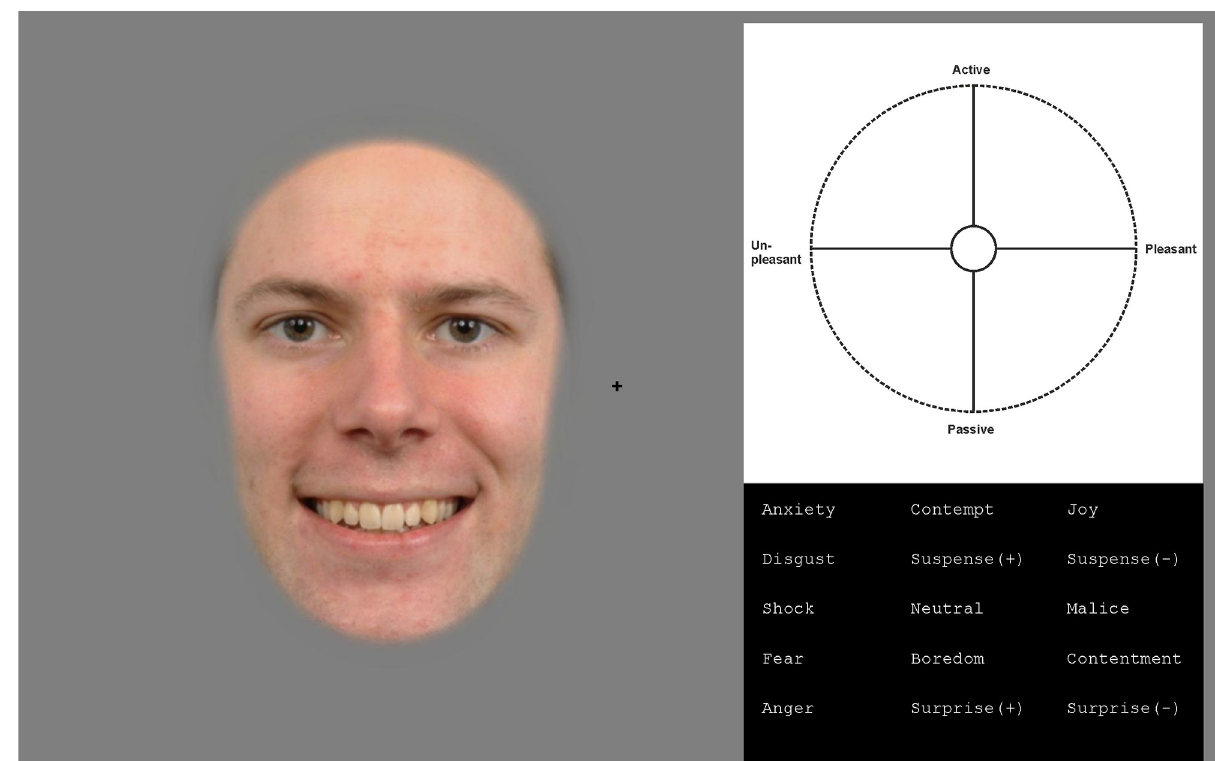
Fig 1. Example of the stimulus display presented to participants at the beginning of a trial. During each trial one facial image was presented on the left side of the screen and the V-A space and the term list (black background) on the right side of the screen. The participants’ task was to first give a rating within the V-A space (top right) and then to select 1–2 terms (bottom right) that best described the emotional expression of the presented face. The participant had up to 3.5 seconds to view the facial image on left, after which it disappeared. The expression portrayed in the example here represents a happy mouth combined with neutral eyes. The example face image is adapted from Radboud faces database (http://www.socsci.ru.nl:8180/ RaFD2/RaFD?p=main). The copyright holder, Radboud faces database, has given a written informed consent to publish this image.